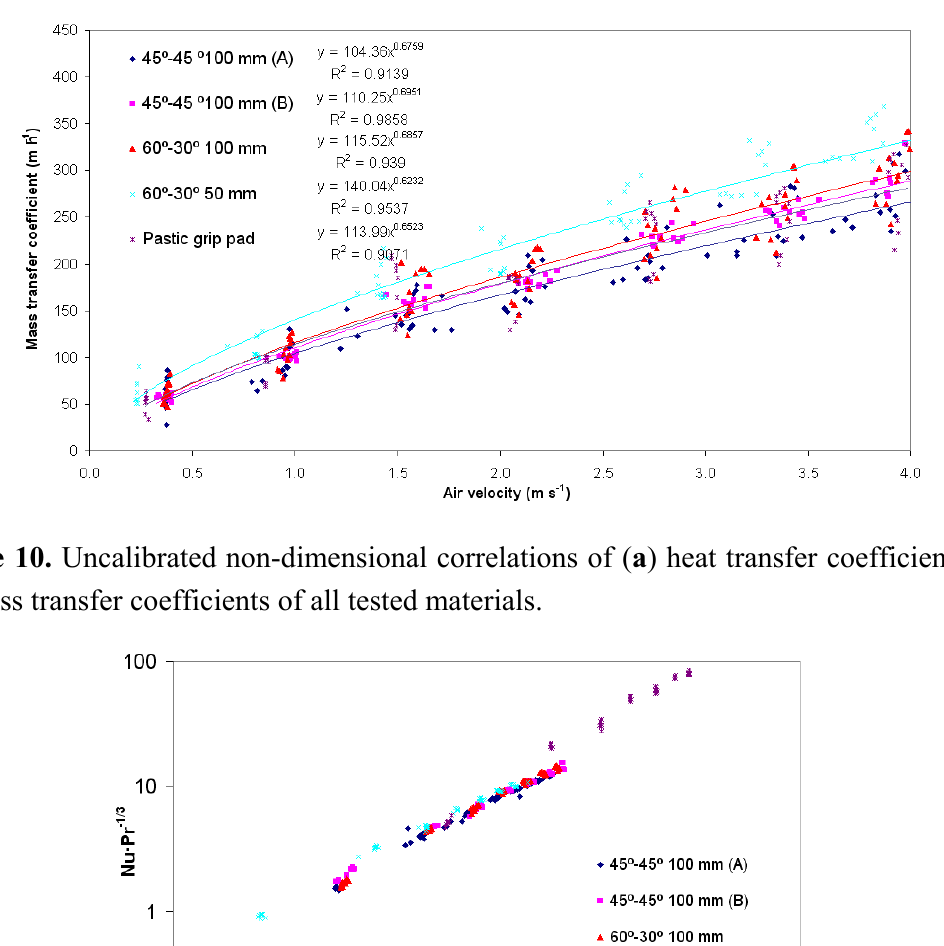
Figure 9. Comparison of the mass transfer coefficients of the cellulose pads and the plastic grid block at different air velocities and water flows.